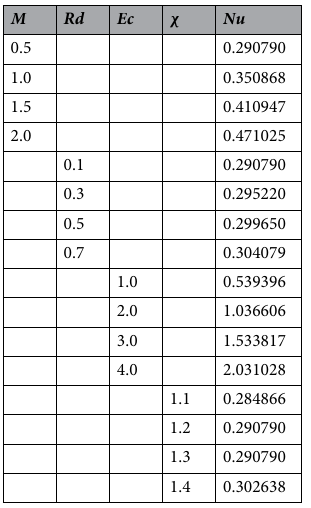
Table 4. Influences of M , Rd , Ec and χ on Nu